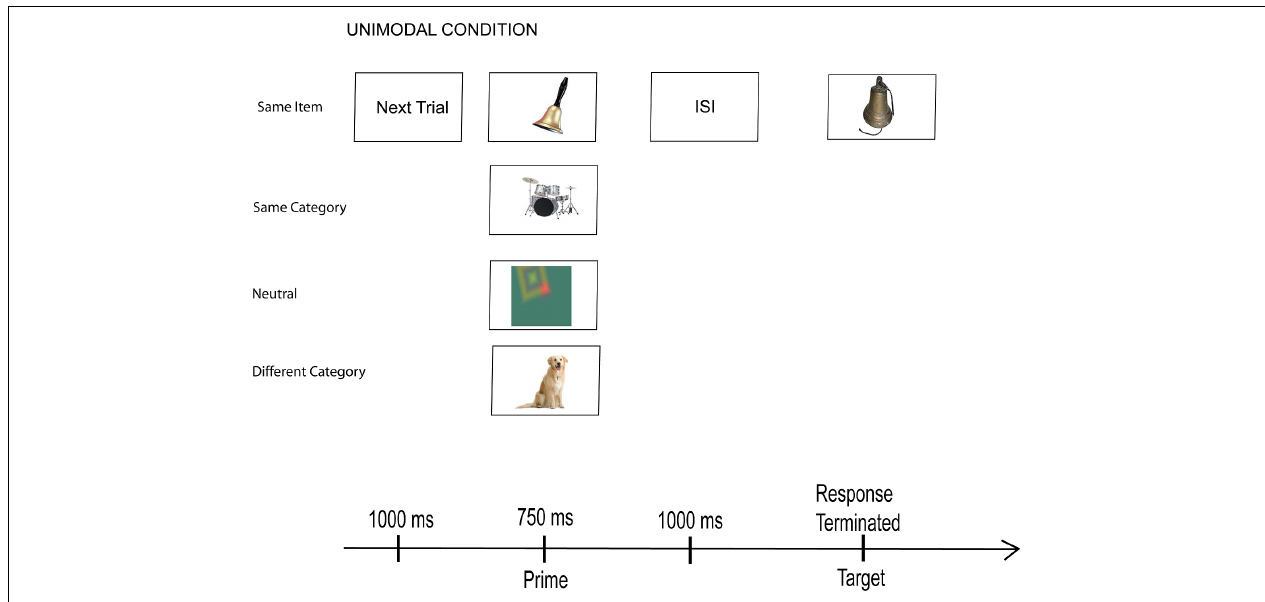
FIGURE 1 | Sequence of events on every trial. An example of the four unimodal conditions with picture targets from Experiment 1.